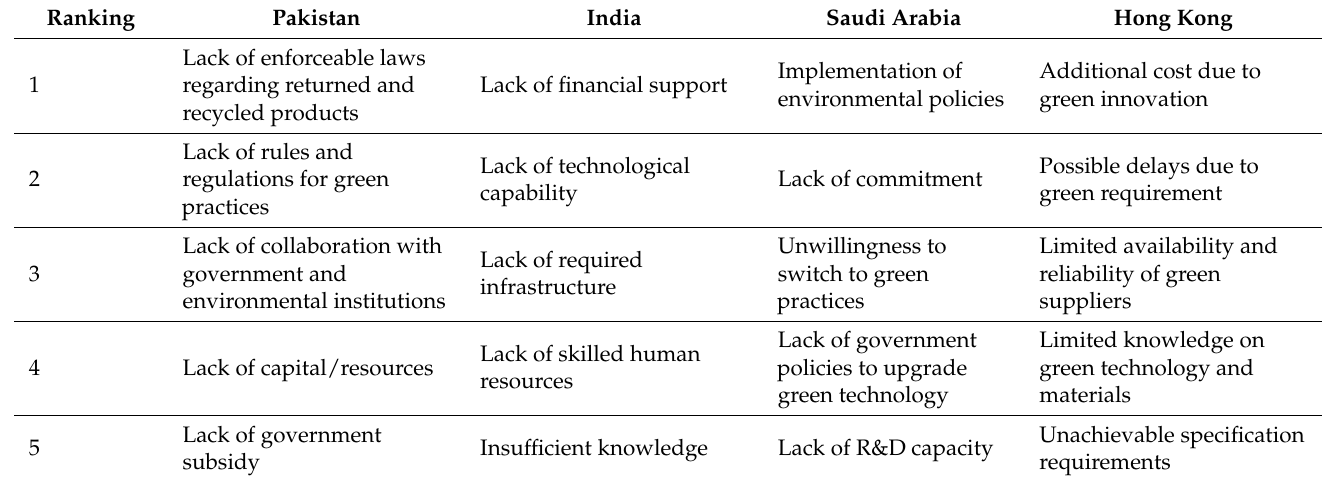
Table 7. Comparison of green innovation barriers in different